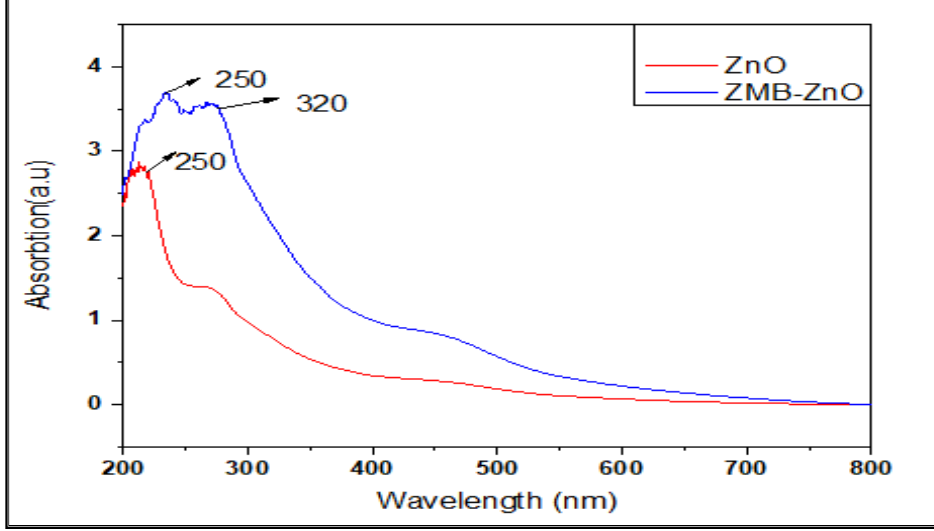
Figure 9. UV pattern of the ZnO and MB-ZnO.